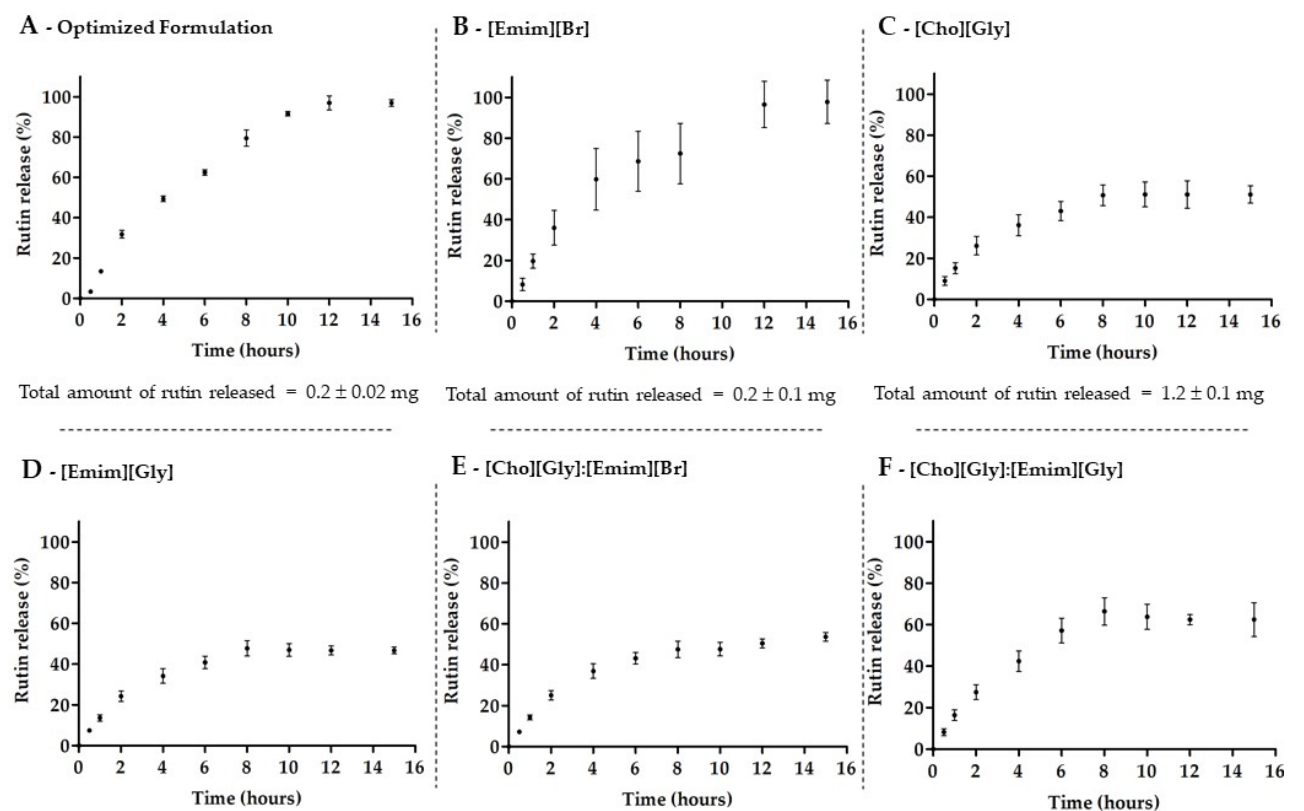
Figure 3. Release profile of rutin from transfersomes, in the absence of ILs ( A ), in the presence of each IL, [Emim][Br] ( B ), [Cho][Gly] ( C ), or [Emim][Gly] ( D ), or of their combinations, [Cho][Gly]:[Emim][Br] ( E ), or [Cho][Gly]:[Emim][Gly] ( F ), during 15 h in phosphate-buffered saline at pH 7.4 (mean ± SD, n = 3).